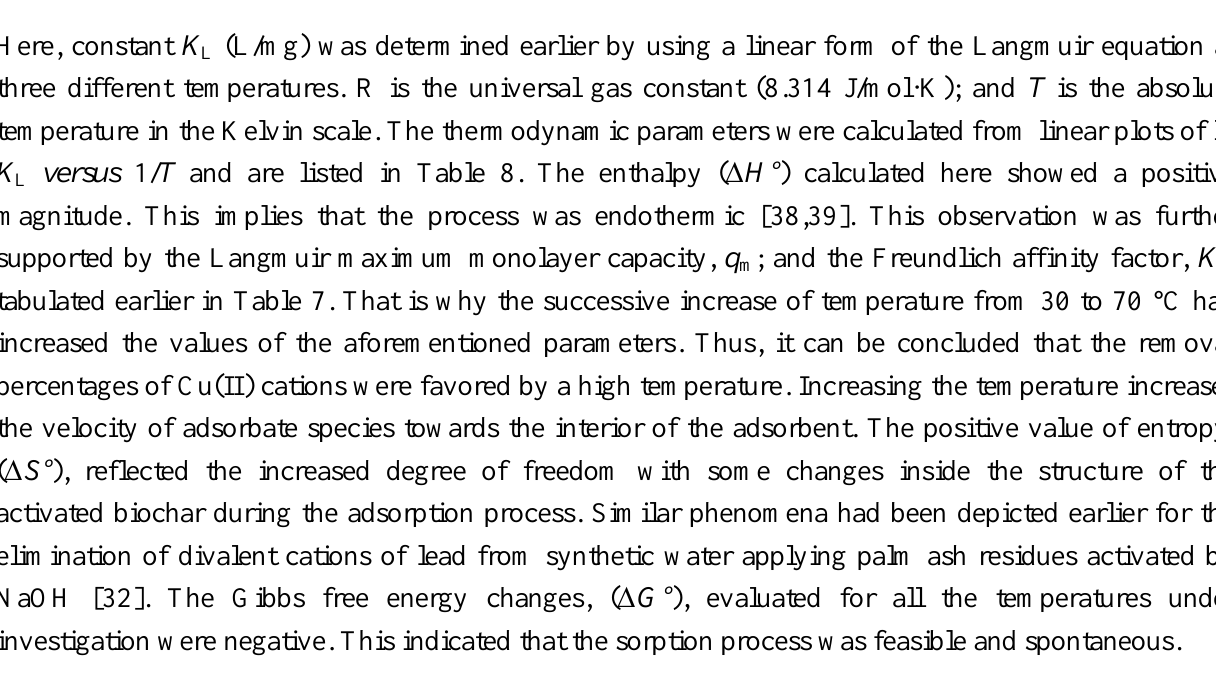
Table 7. Langmuir, Freundlich and Temkin model parameters at different temperatures.